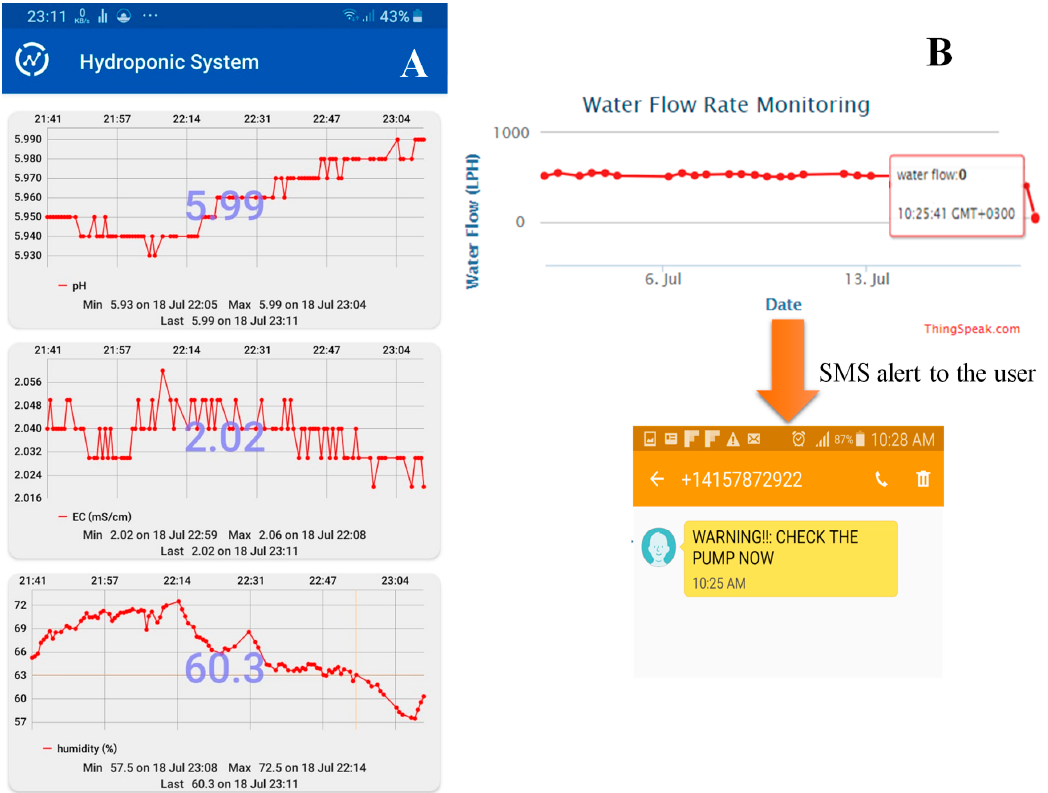
Figure 10. Mobile Application interface for the hydroponic system ( A ) and SMS sent to alert the user when the pump is not working ( B ).